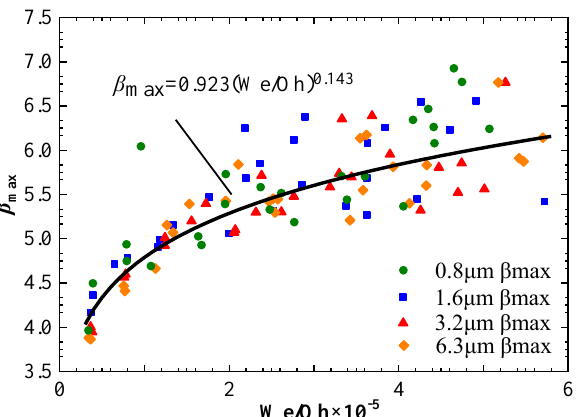
Figure 10. Experimental data and model prediction of β max by the new empirical formula of droplet impinging on four different roughness surfaces.